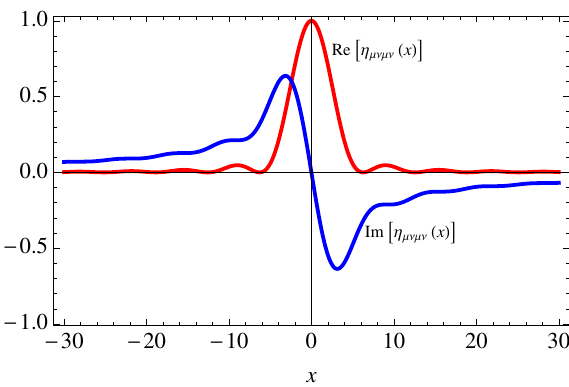
Figure 10: Plot of Eqs. (5) and (6), real and imaginary part of the coupling constant η µνµν